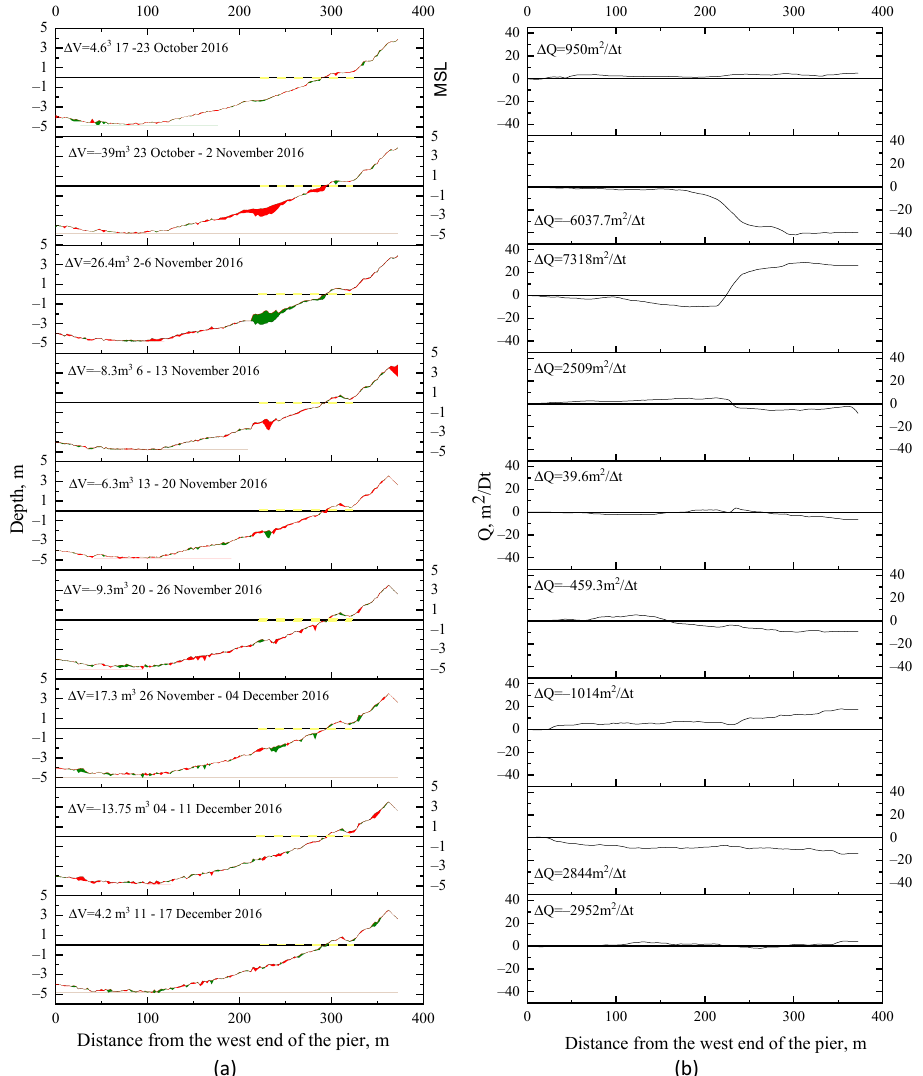
Figure 9. ( a ) Cross-shore profile changes (green-sand accumulation, red-sand loss) and ( b ) sediment transport rate Q in 2016.